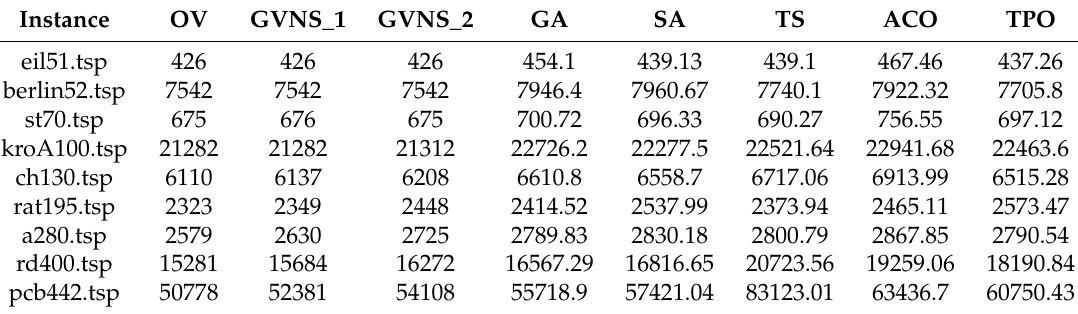
Table 18. Comparisons between GVNS_1 and GVNS_2 with BI for 2mins with the recent work of Halim et